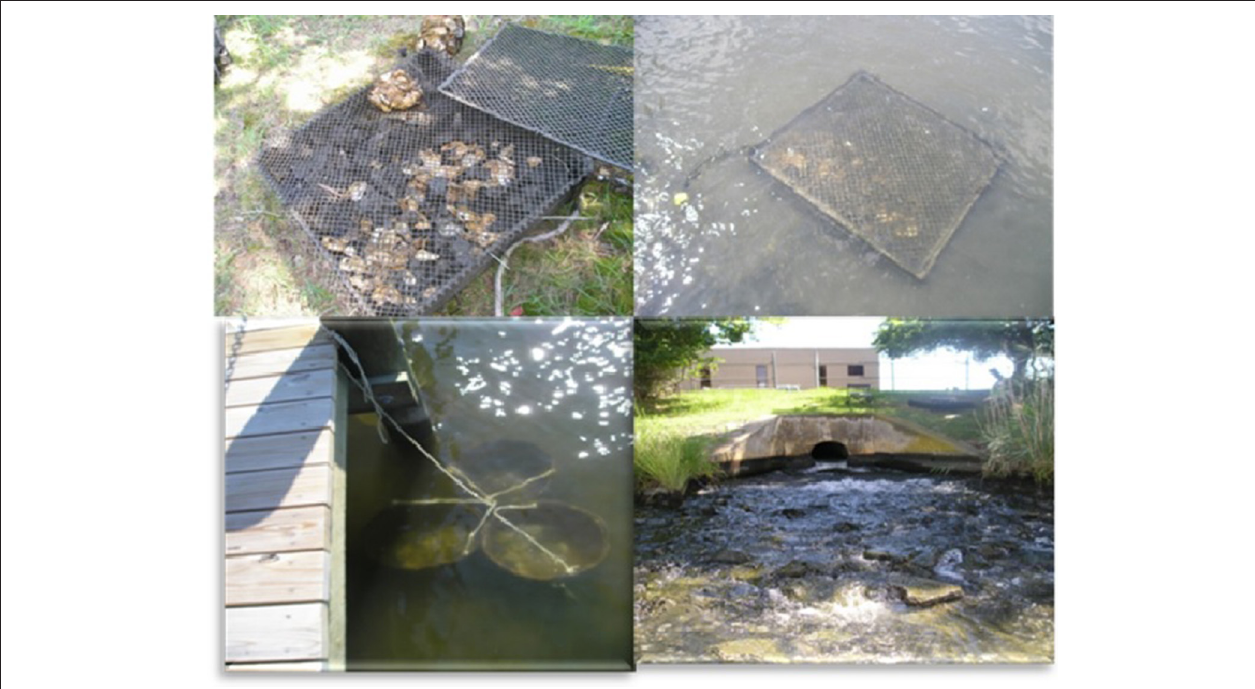
FIGURE 4 | Study locations near the Rehoboth Beach Wastewater Treatment Plant in Rehoboth Beach, Delaware (Cannon et al., in press).